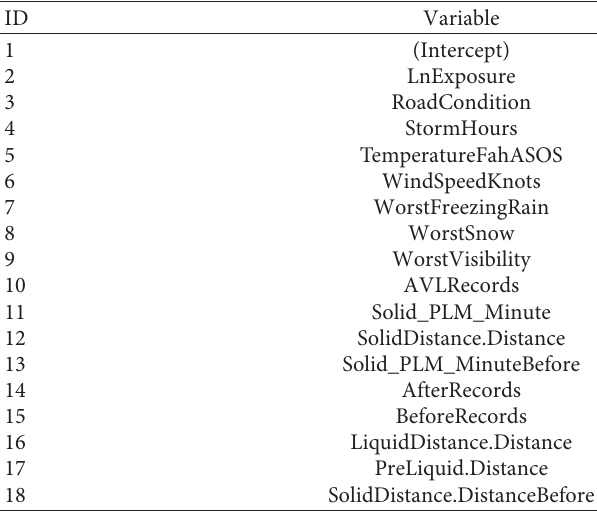
Table 5: List of the trimmed